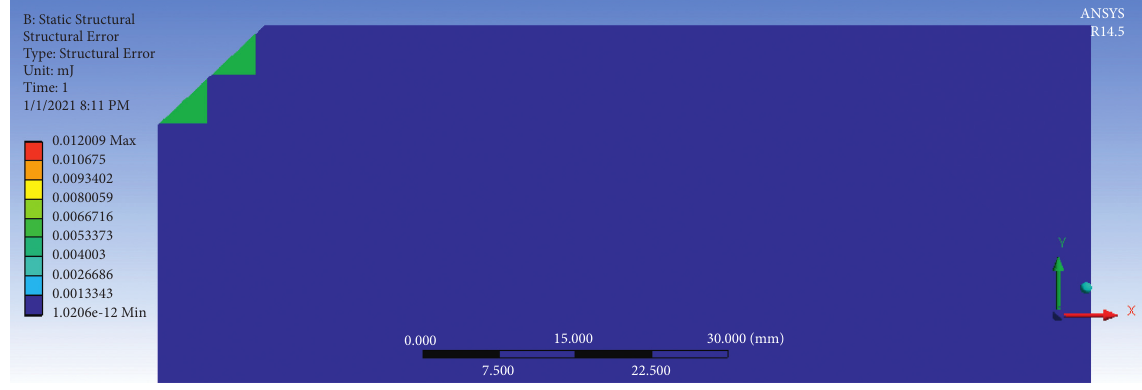
ANSYS R14.5B: Static Structural